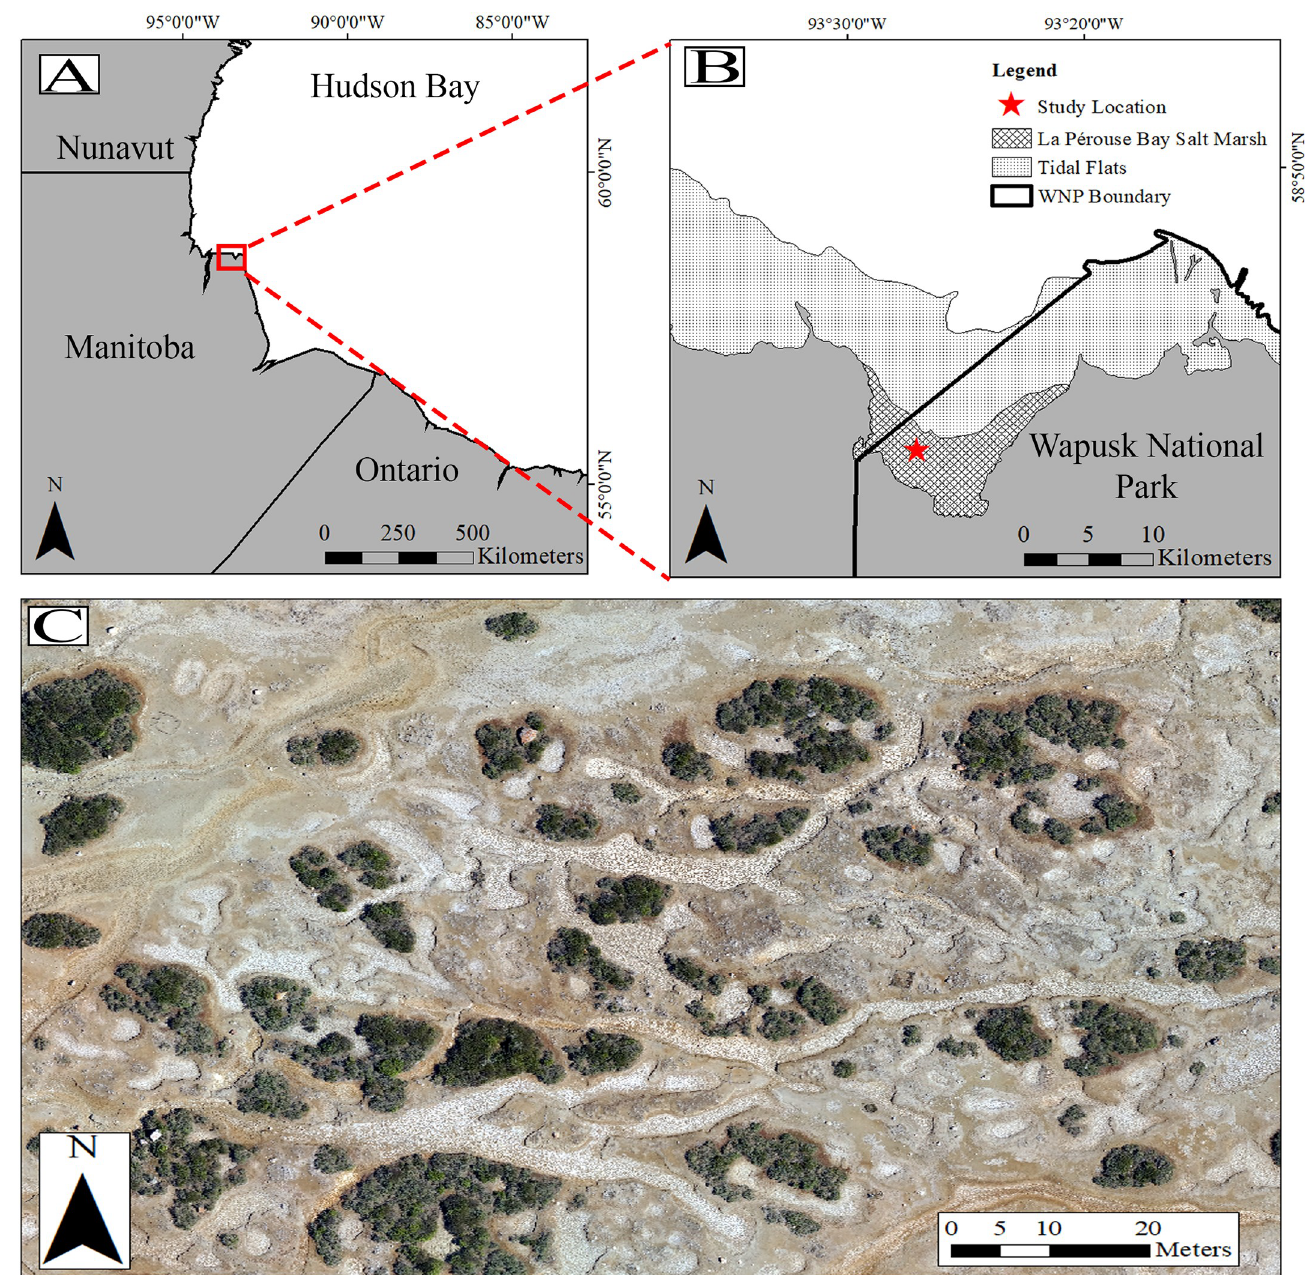
Fig 1. Map of study location. (A) Extent indicator of study location in northern Manitoba, (B) supratidal salt marsh study location within Wapusk National Park, (C) sample RGB photo of habitat surveyed by drone. Image acquired at 75 m above ground